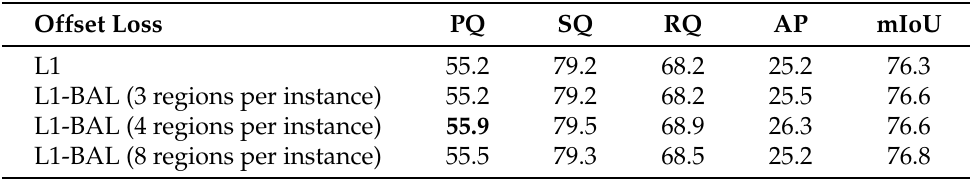
Table 8. Validation of boundary-aware offset loss for the PSN-RN18 PYRx3 model on Cityscapes val. The presented results are average over two